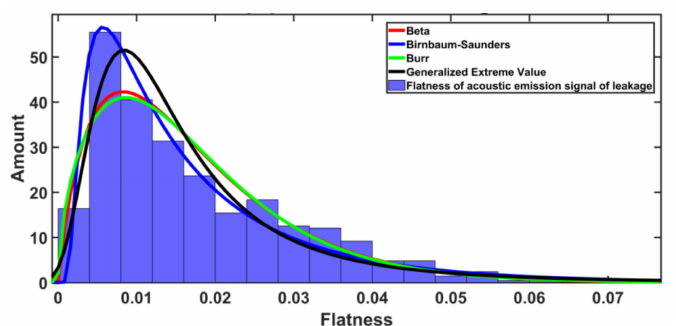
Figure 13. Comparison of the distributions fitting the spectral flatness of the acoustic emission signals of WDSs with a leakage.